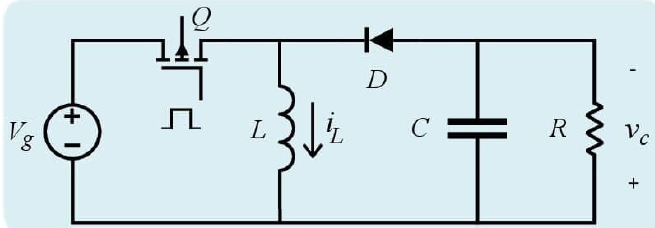
Figure 1. Electrical diagram of the DC–DC (direct current) buck–boost